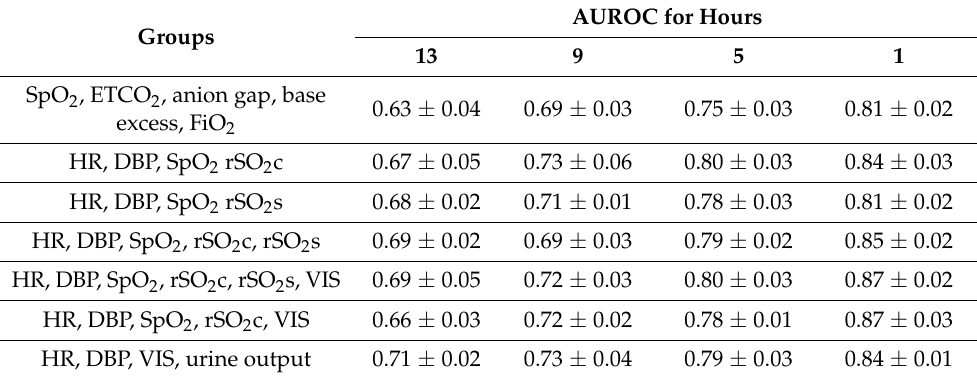
AUROC for Hours 13